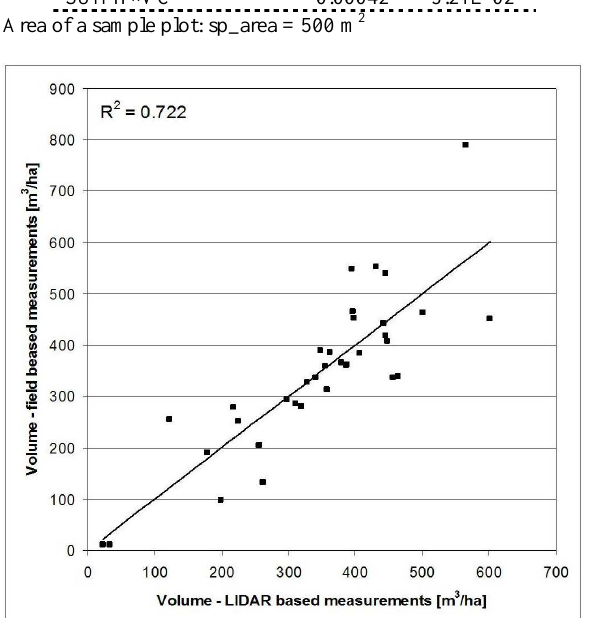
Figure 4. Determination value between live trees volume calculated based on field measurements and calculated from LIDAR based characteristics (SUMH, VC, CAR,